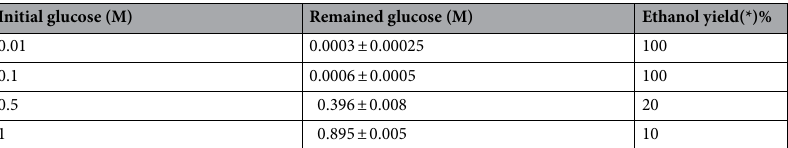
Table 2. Bioethanol production and remaining glucose at different glucose concentrations in Z. mobilis crude extract. (*)Ethanol yield is presented as a percentage of the maximum theoretical